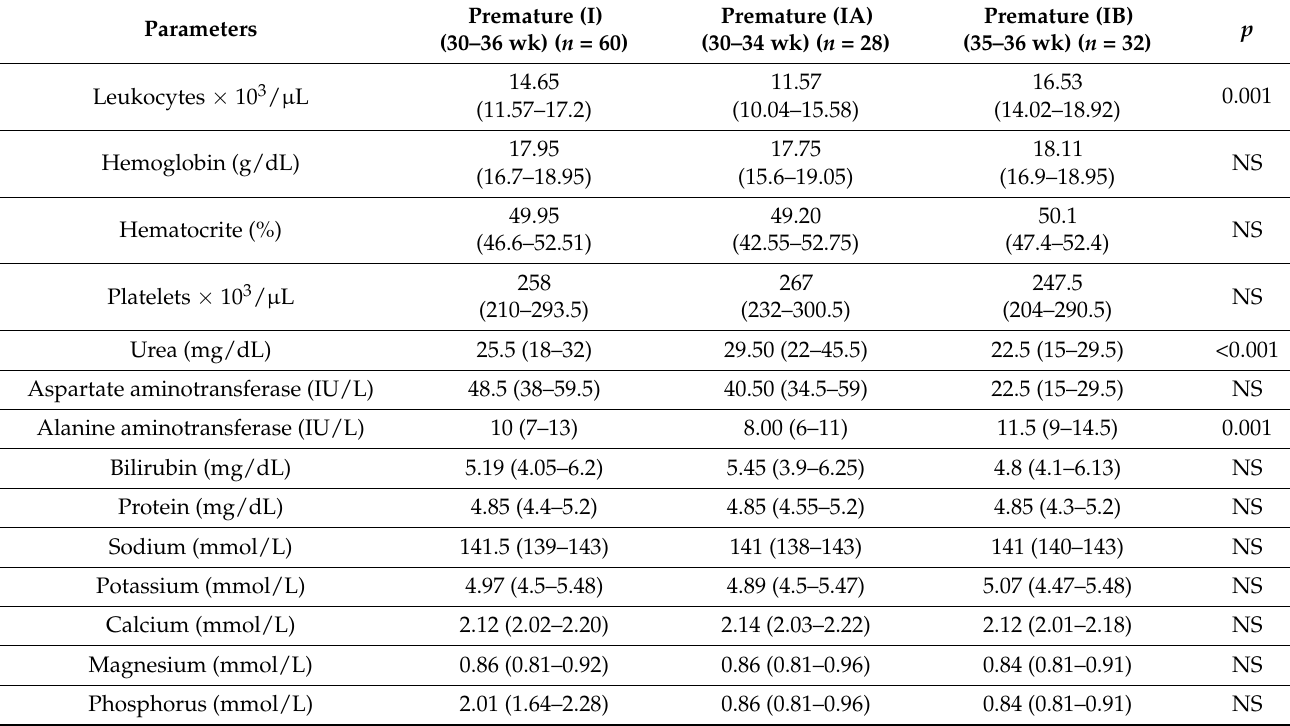
Table 2. The results of basic laboratory tests of premature